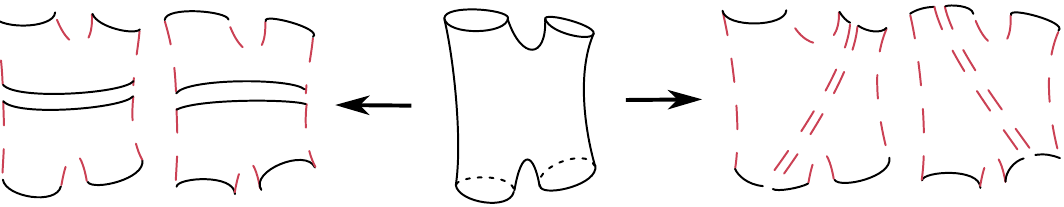
Figure 1 . The lowest-genus four-point function is topologically a sphere with four punctures corresponding to the closed-string states (middle). There are two way to tessellate this object in hexagonal patches. On the left, we cut the four-point function into two three-point functions, like in the operator-product expansion (OPE), and tessellate them with hexagons. This requires summing over all intermediate physical states (solid lines). In the right-hand panel, the cut is only along mirror edges (dashed lines), so we only need to sum over all possible exchanges of mirror